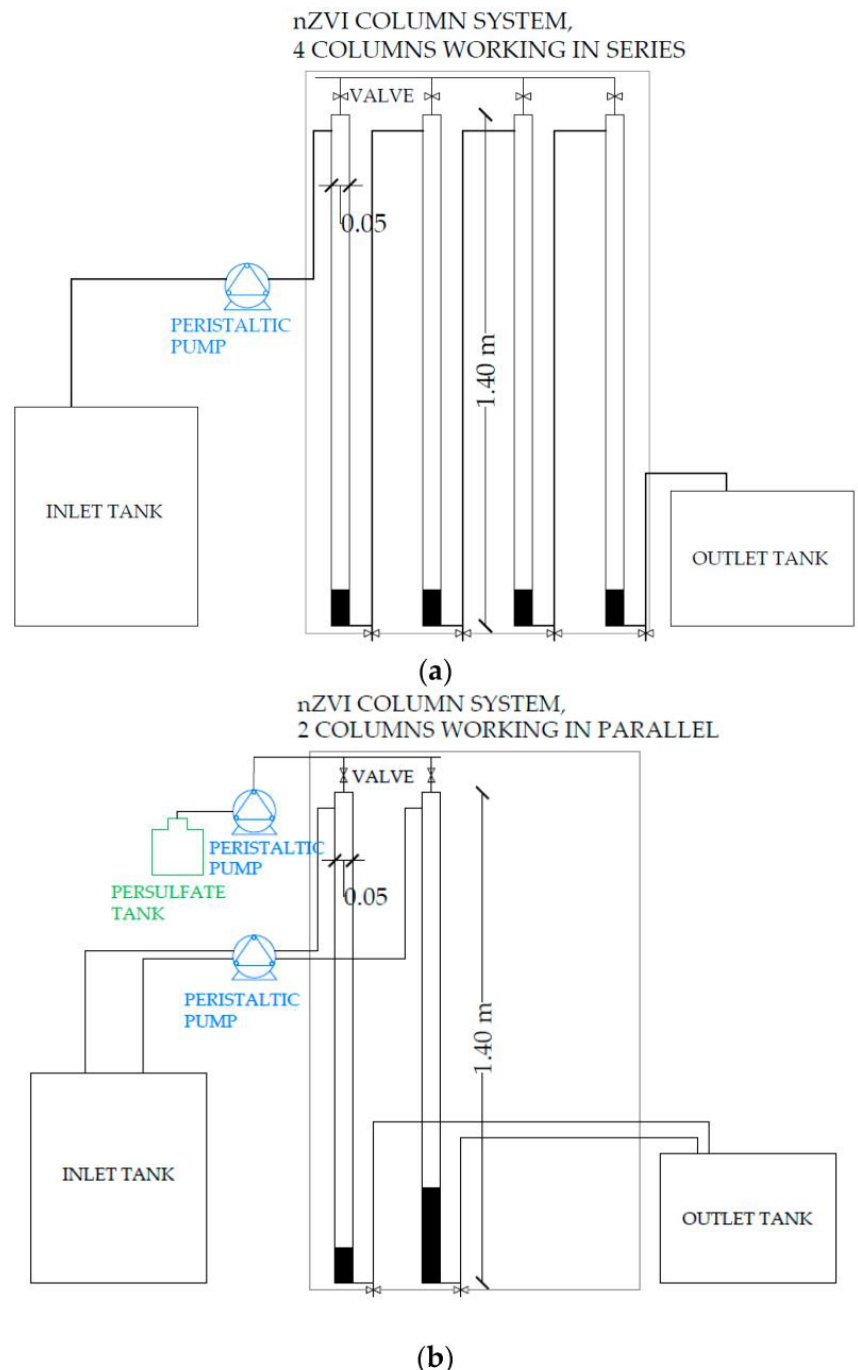
Figure 1. The general configuration of the nZVI column system working in series ( a ) and working in parallel ( b